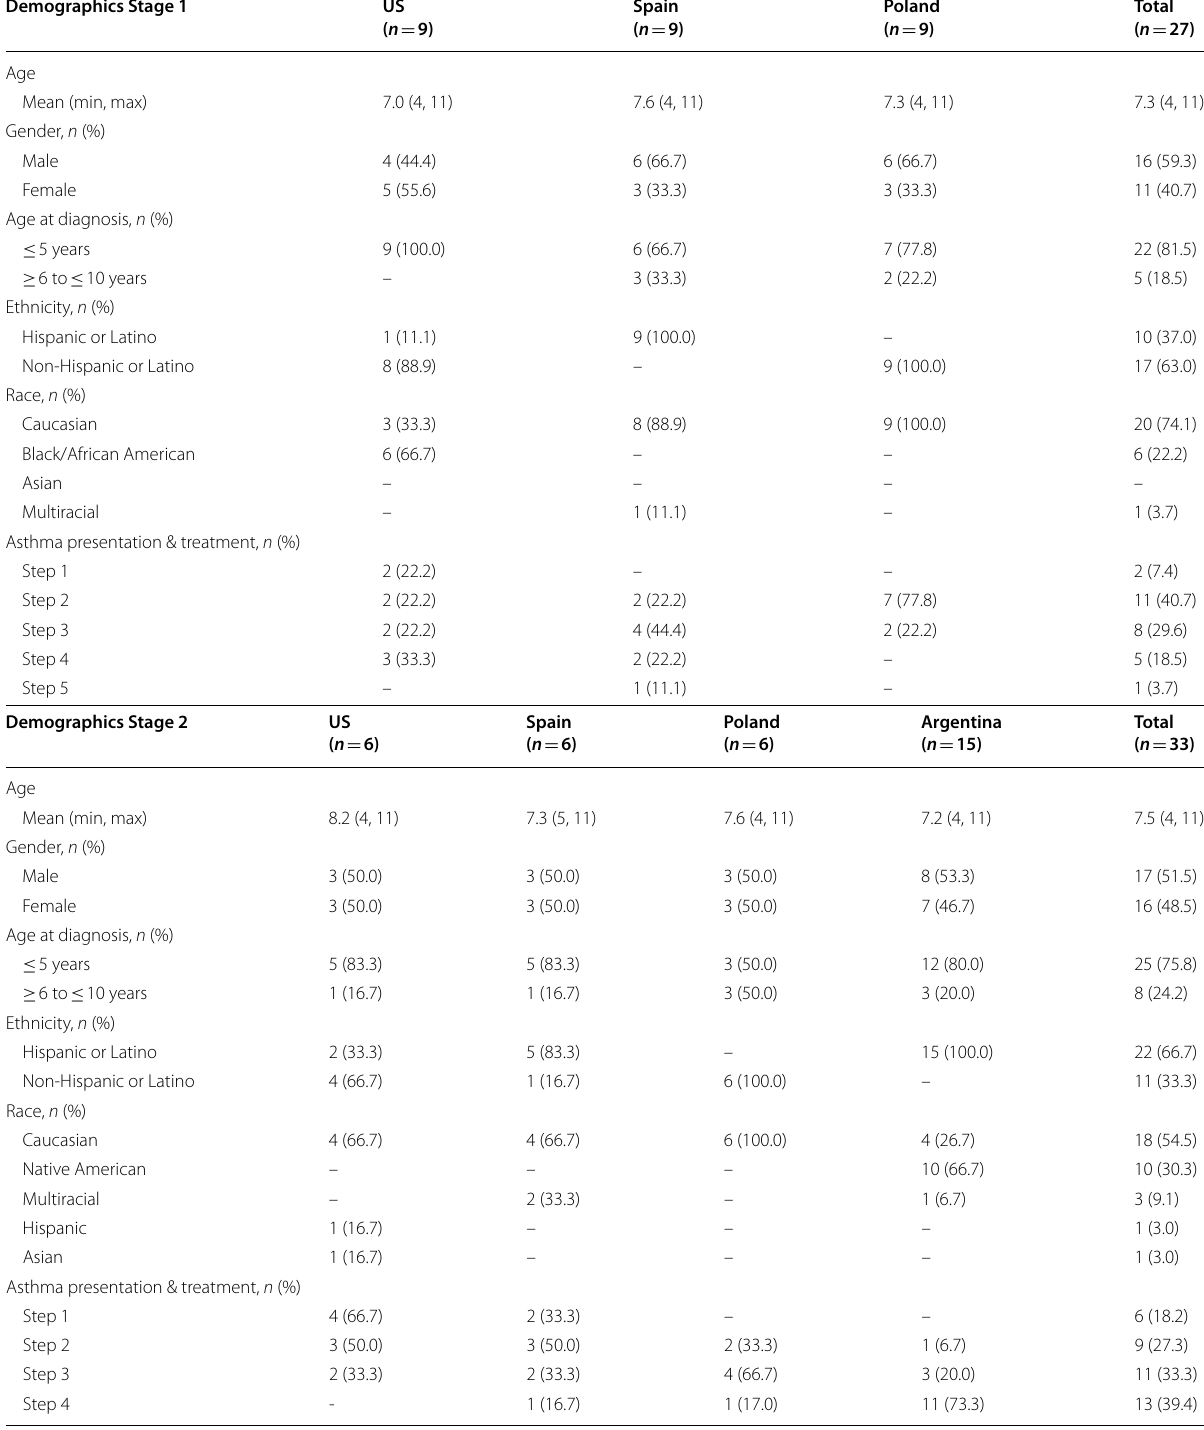
Table 1 Demographic and baseline characteristics of children for Stage 1 and Stage